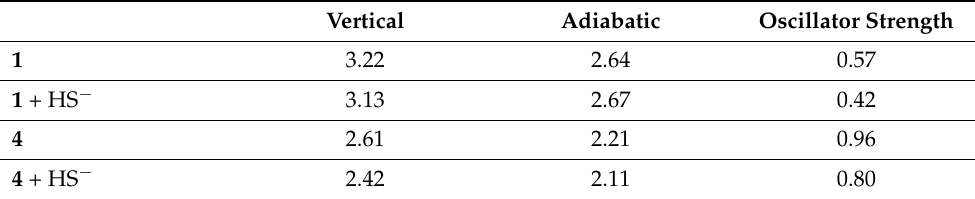
Table 1. Computed vertical and adiabatic excitation energies (eV) and oscillator strength for the S 1 ← S 0 transitions. Vertical Adiabatic Oscillator Strength